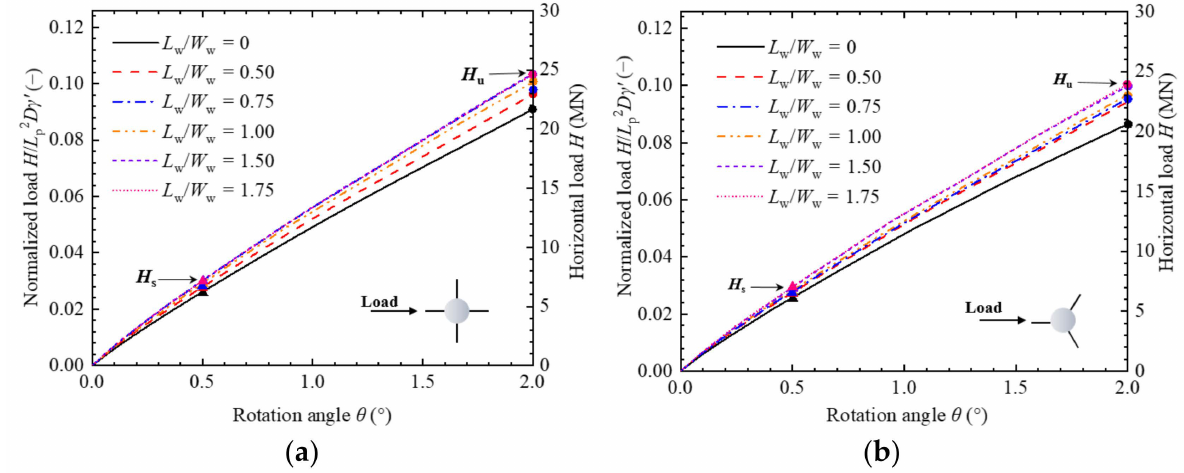
Figure 19. Variation in the lateral bearing capacity of winged monopiles under different wing heights: ( a ) four-wing monopiles; ( b ) three-wing